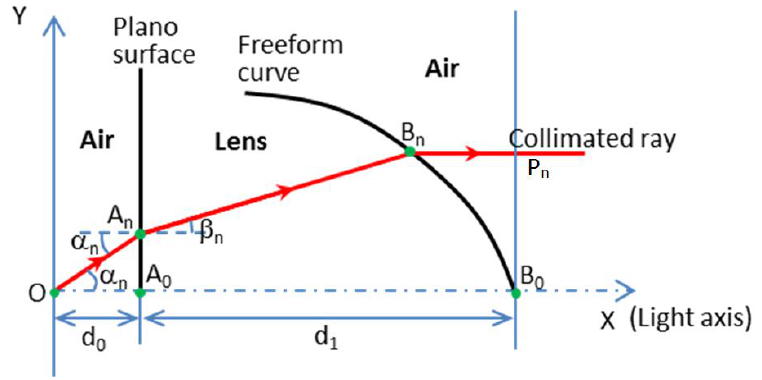
Figure 3. Design principle of the plano-convex lens based on freeform optics.